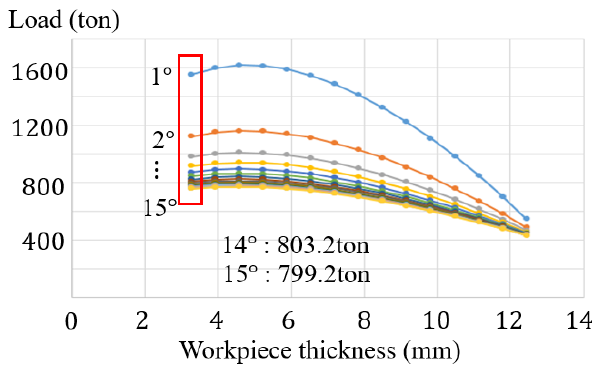
Figure 6. Die angle (α) between material and die .